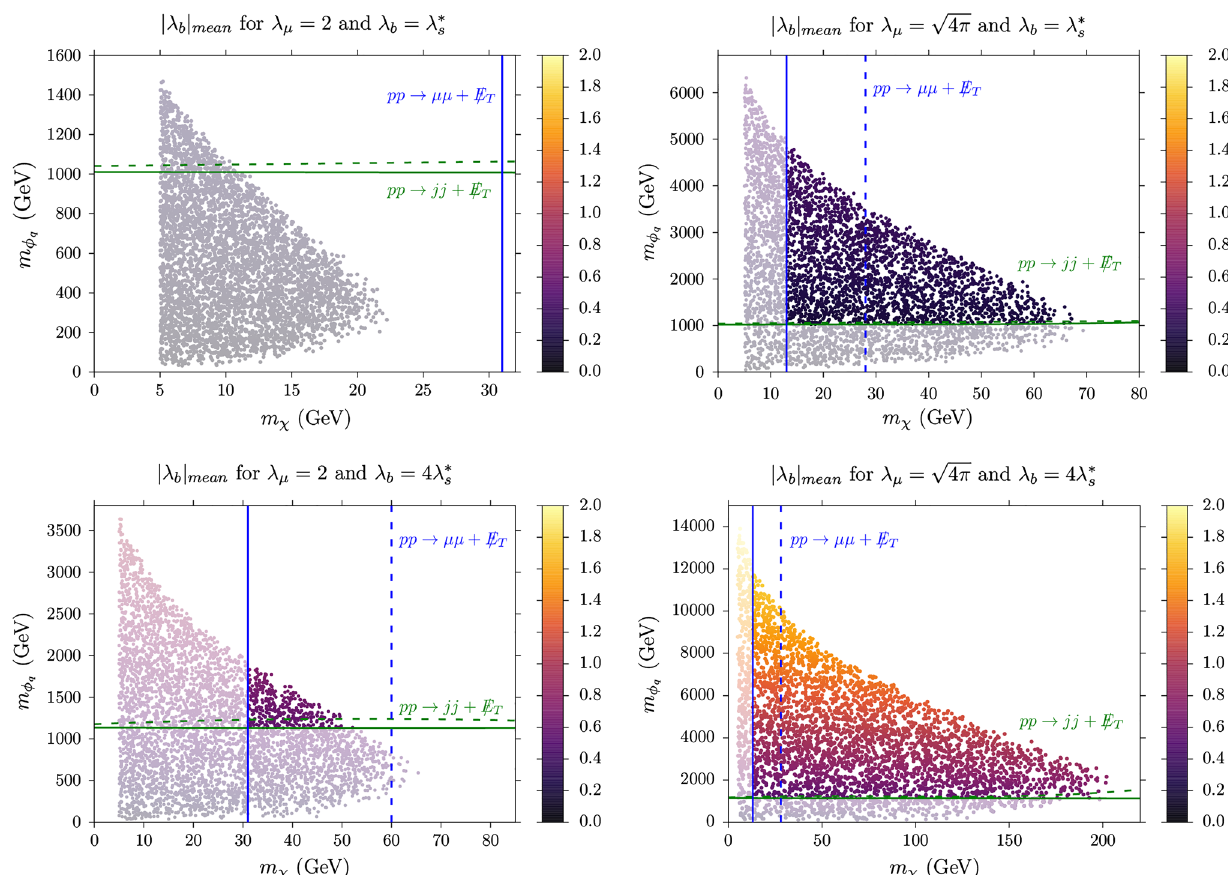
Fig. 6 LHClimitsfromthe pp → jj + E T / (green)and pp → μμ + E T / (blue)searches.Ontheleft(right),resultsforthescenariowith | λ μ | = 2 √ 4 π ) are presented. The figures in the upper panel correspond ( | λ μ | = to λ b = λ ∗ s , while the bottom panel shows limits for λ b = 4 λ ∗ s . The